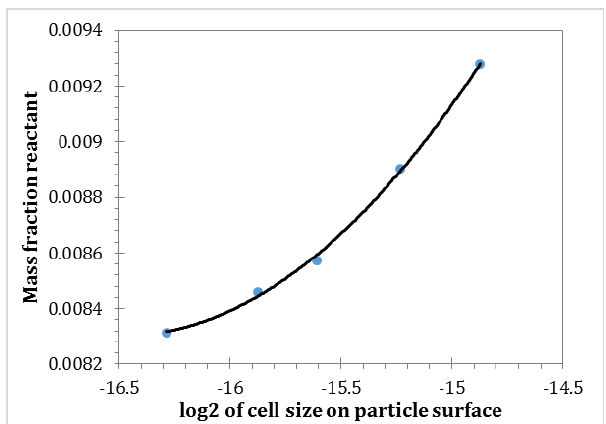
Figure 1. Grid independence behavior for the variation of mass fraction of specie A (x A ) at a plane perpendicular to the flow near the outlet (2 planes below the outlet) in array of spherical particles with respect to particle surface mesh resolution, simulated at dH rxn = −10 kJ/mol, Pr = 1, ε = 0.351, and 𝜙 = 10. Symbols represent the results and the line is the exponential function: x A = 0.008048 + exp (9.7158 + 1.1035log 2 (𝑑𝑥)) , where ( dx ) is the grid size on the particle surface.